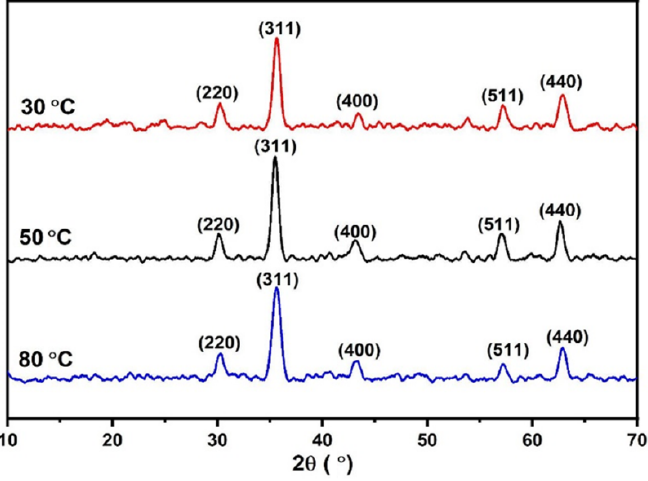
Figure 2. XRD patterns of SPIONs recorded at 30 °C, 50 °C, and 80 °C.